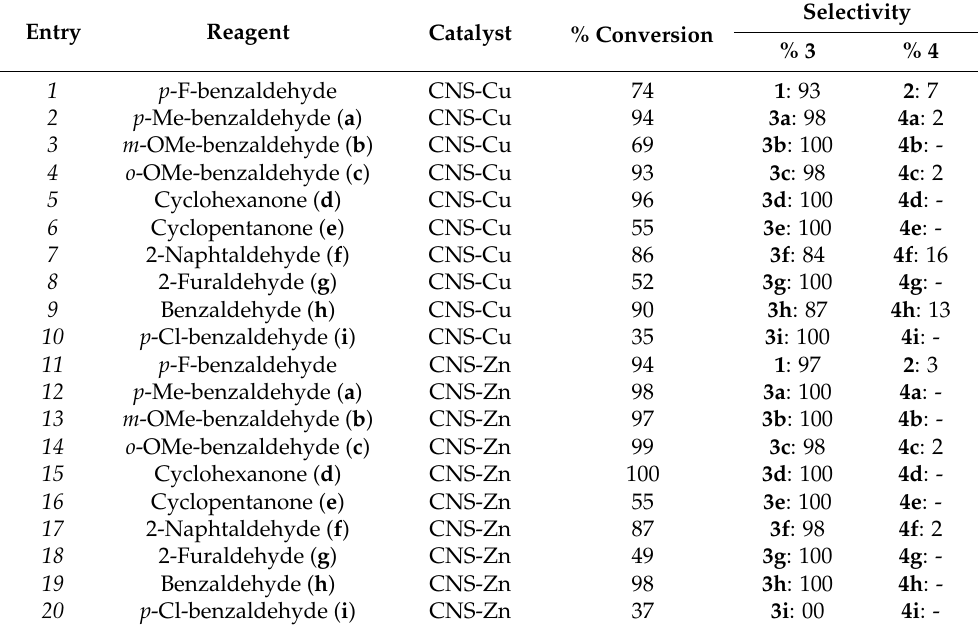
Table 7. Reactions with different carbonyl compounds using methanol as solvent *.